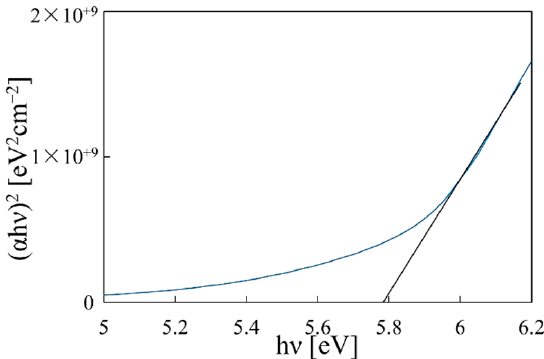
Figure 5. Bandgap evaluation of the Mg(OH) 2 film.